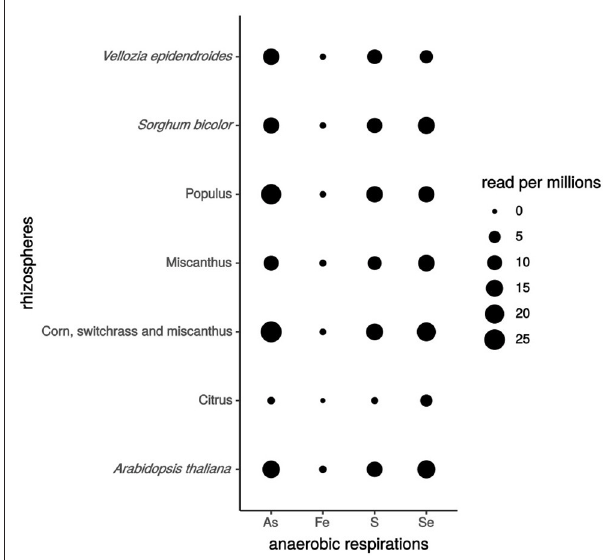
FIGURE 2 | Anaerobic respiration gene expression in different plant rhizospheres. The number of hits per 10 6 reads expressed the level of genes expression. As for Arsenate, Fe for iron, S for sulfur and Se for selenate. Rhizospheric metatranscriptomics bioprojects accession numbers: